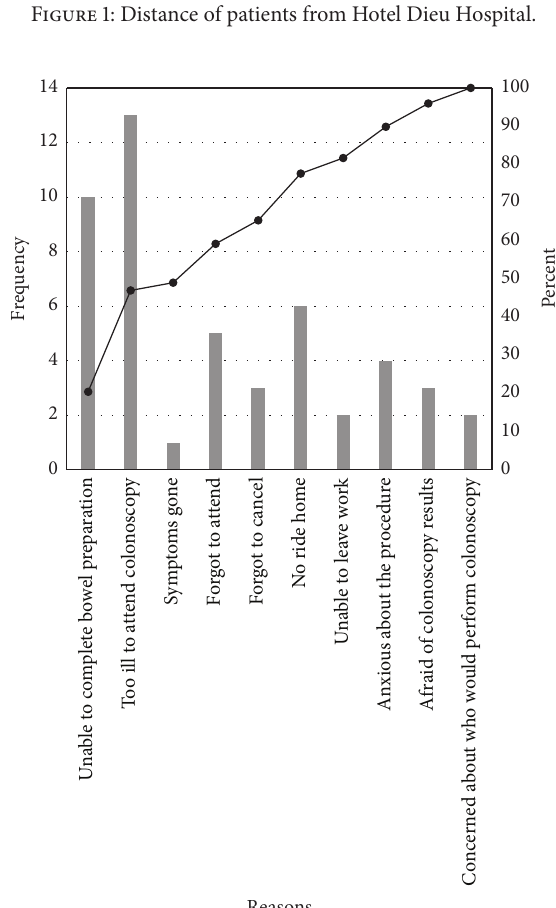
Figure 2: Top reasons for missed